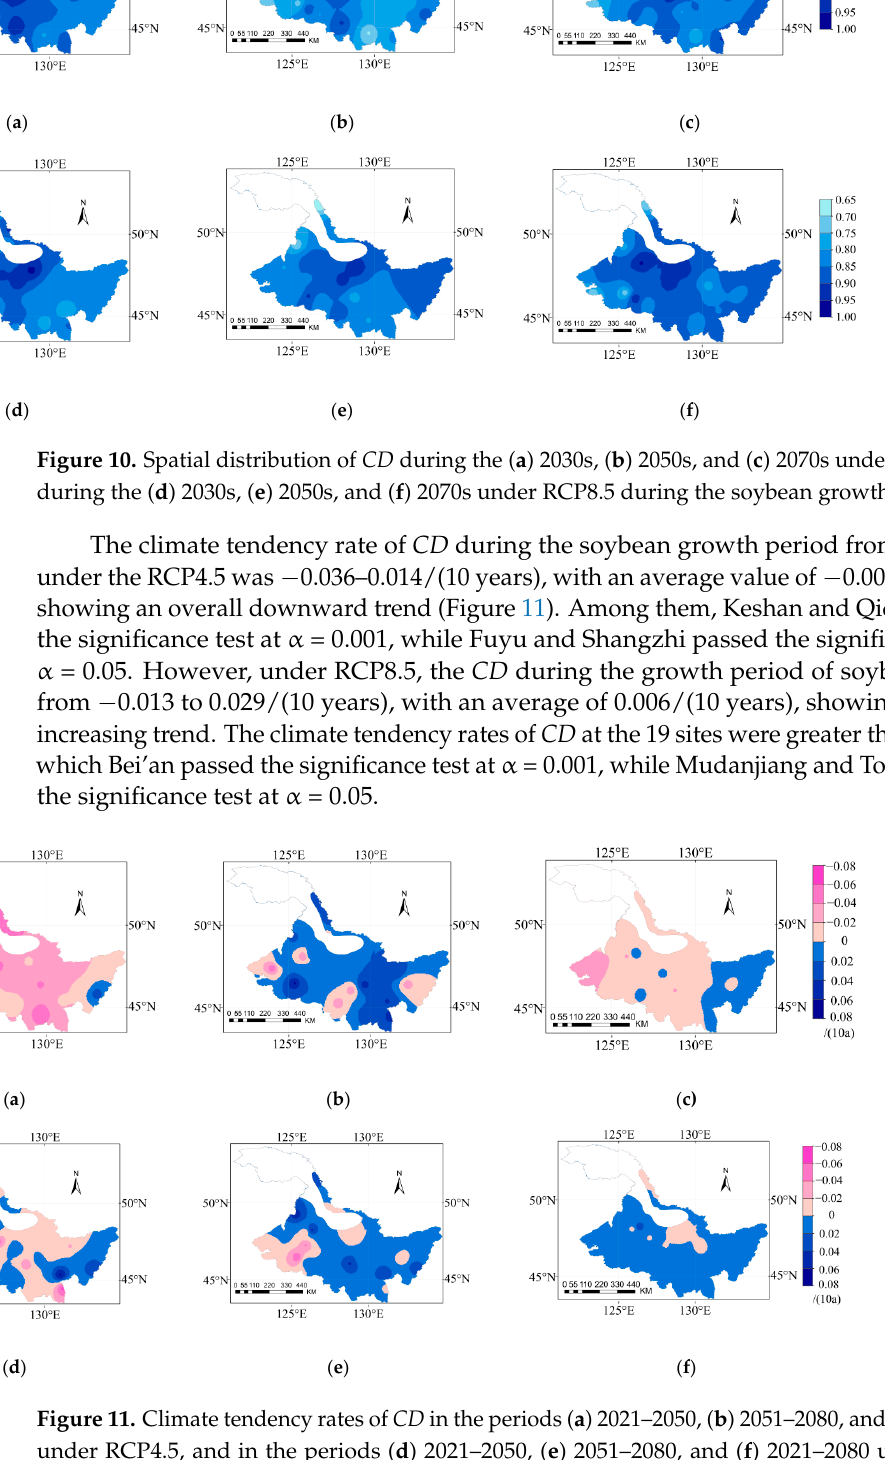
Figure 11. Climate tendency rates of CD in the periods ( a ) 2021–2050, ( b ) 2051–2080, and ( c ) 2021–2080 under RCP4.5, and in the periods ( d ) 2021–2050, ( e ) 2051–2080, and ( f ) 2021–2080 under RCP8.5 during the soybean growth period.